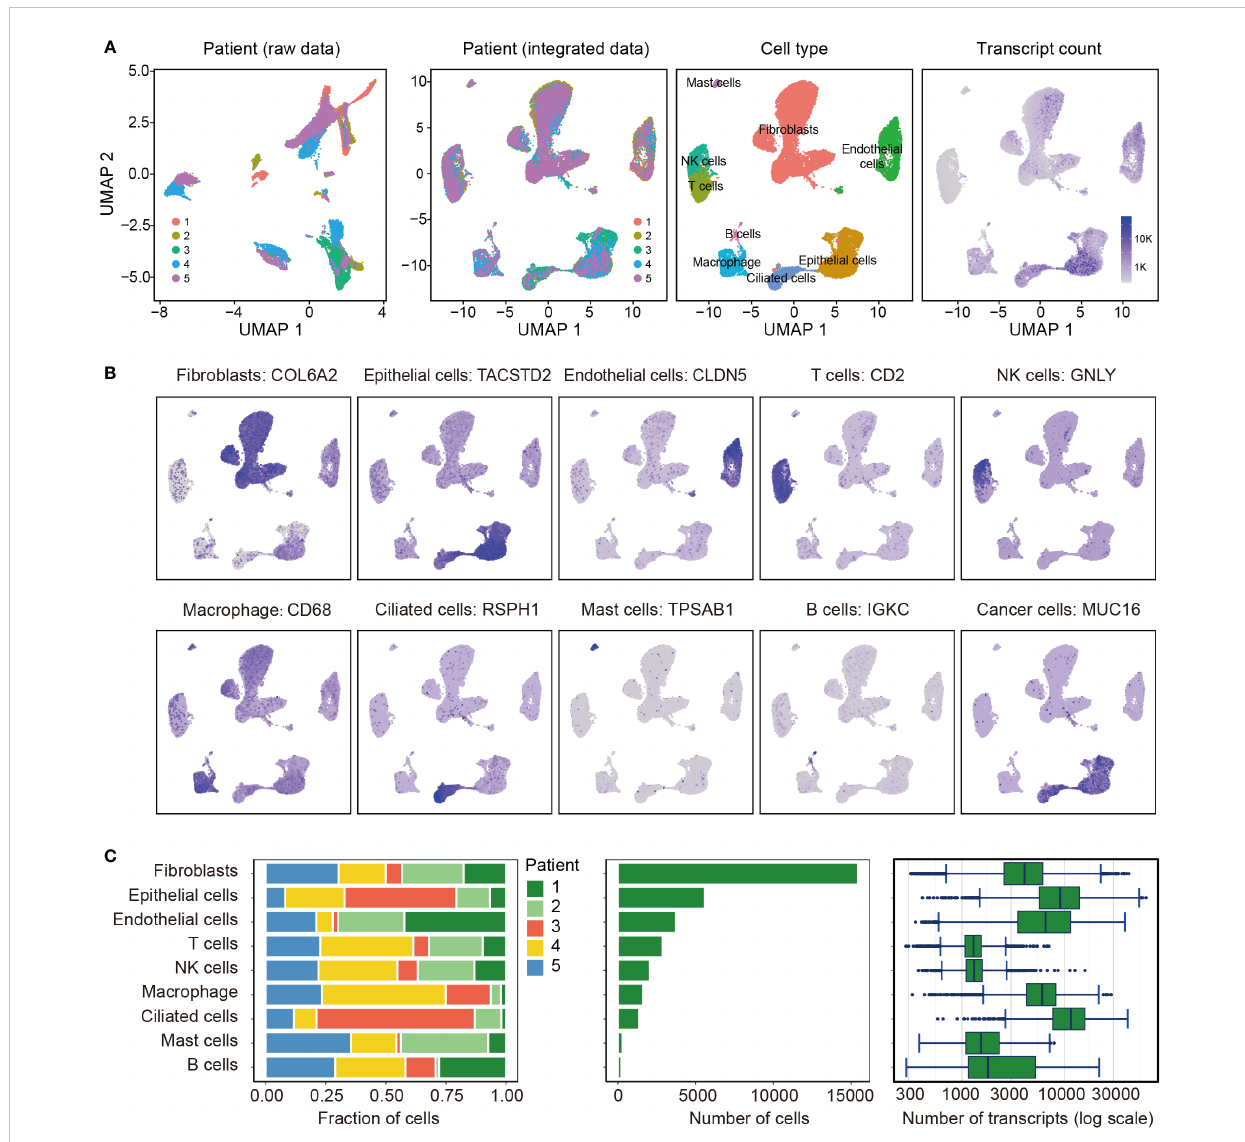
FIGURE 1 Overview of the 33,162 single cells from endometrioid carcinoma. (A) Uniform manifold approximation and projection (UMAP) of the 33,162 cells pro fi led here, with each cell color coded for (left to right): the corresponding patient in raw data and integrated data, the associated cell type and the number of transcripts (UMIs) detected in that cell (log scale as de fi ned in the inset). K, thousand. (B) Expression of the representative marker genes for the cell types. (C) For each of the 9 cell clusters (left to right): the fraction of cells originating from each of the 5 patients, the number of cells and box plots of the number of